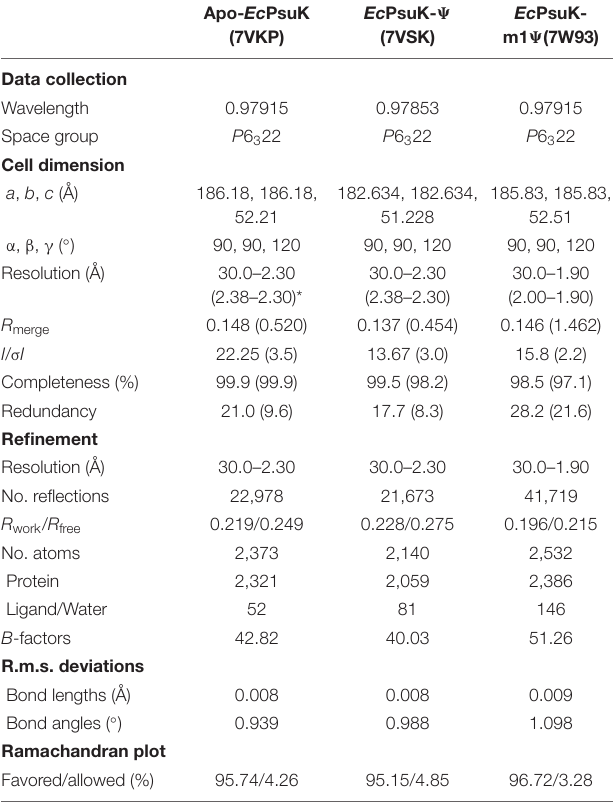
TABLE 1 | Data collection and refinement